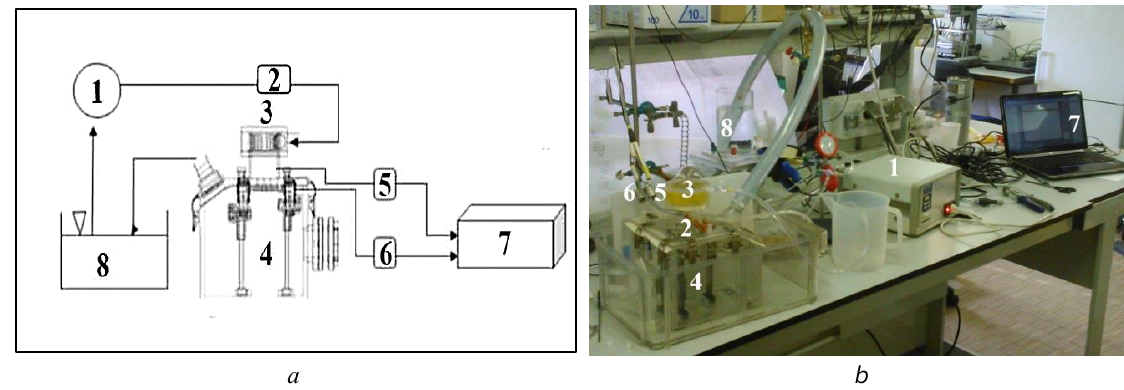
Figure 2. Schematic diagram (a) and photo (b) of the experimental